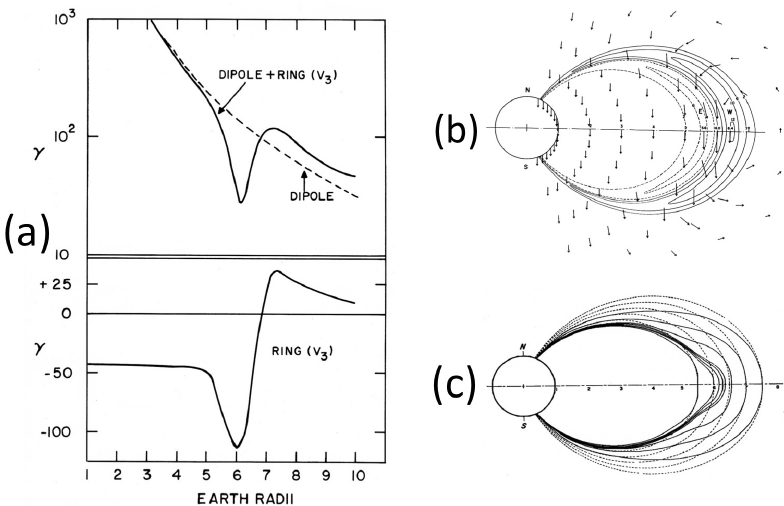
Figure 8. Changes in the earth’s magnetic configuration when magnetic energy is accumulated centered around 6 R E (red dot); (a) the earth’s field change and (b) the distribution of the magnetic field produced by the model ring current. (c) The distortion (inflation) of the magnetic field lines (Akasofu et al., 1961; Akasofu,